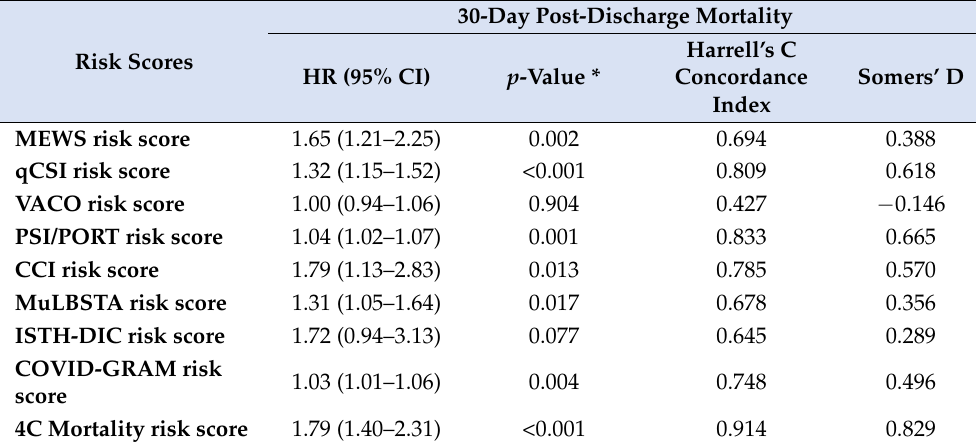
Table 3. Association and discrimination of different risk scores with 30-day post-discharge mortality (univariate Cox proportional hazards logistic regression